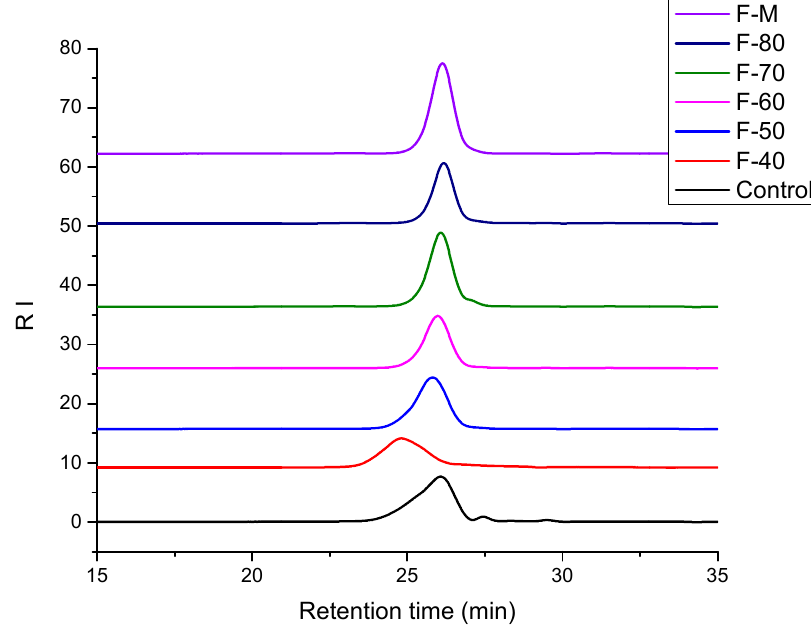
Figure 1. GPC pattern of LD fractions: LD, F-40, F-50, F-60, F-70, F-80, and F-M.